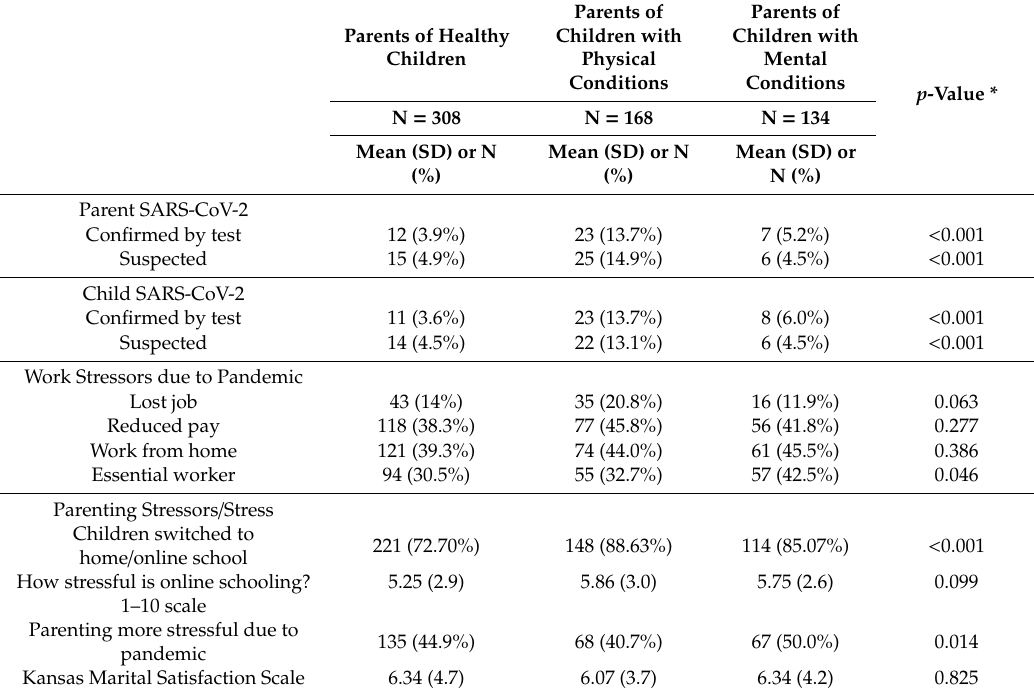
Table 2. Pandemic-related stressors, perceived stress, coping and mental health among parents of healthy children or children with chronic